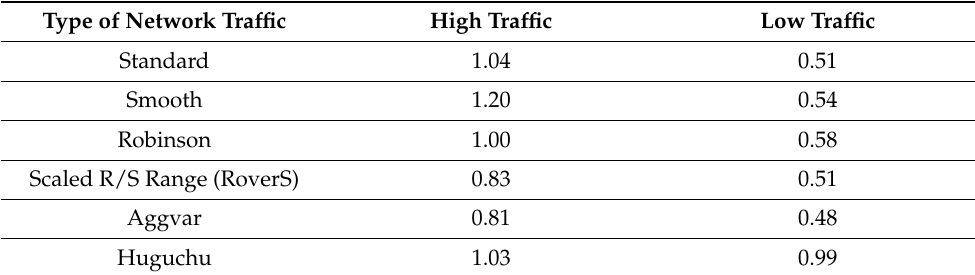
Table 7. Hurst exponent values for two types of network